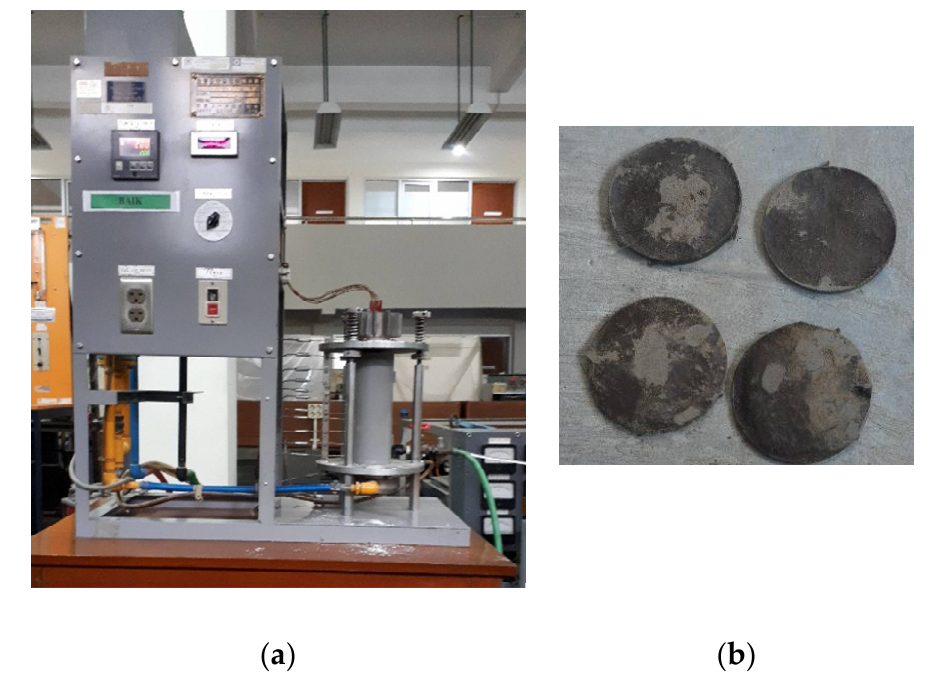
Figure 4. Thermal conductivity test ( a ) and the specimen ( b